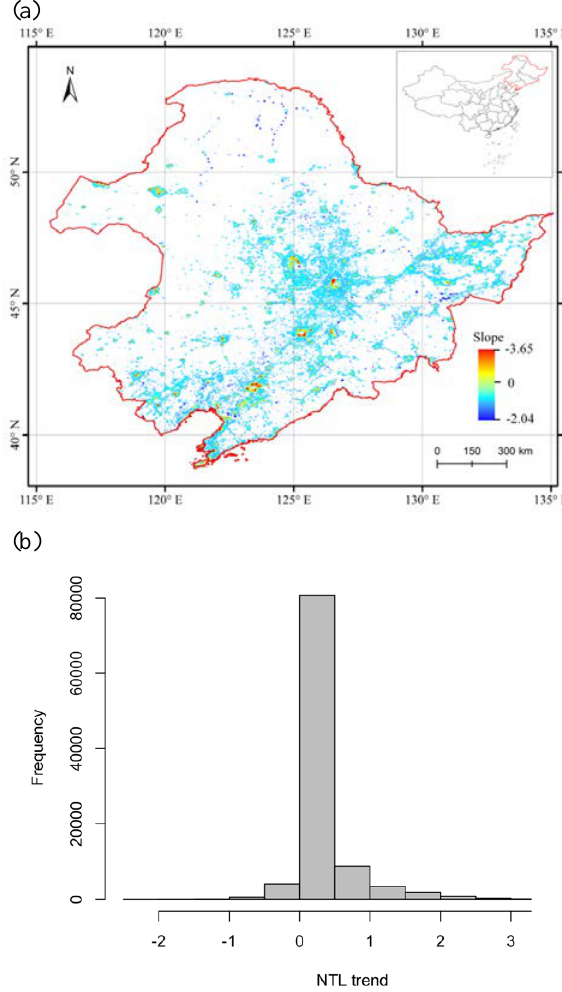
Figure 2. NTL temporal trend (a) and the histogram (b).